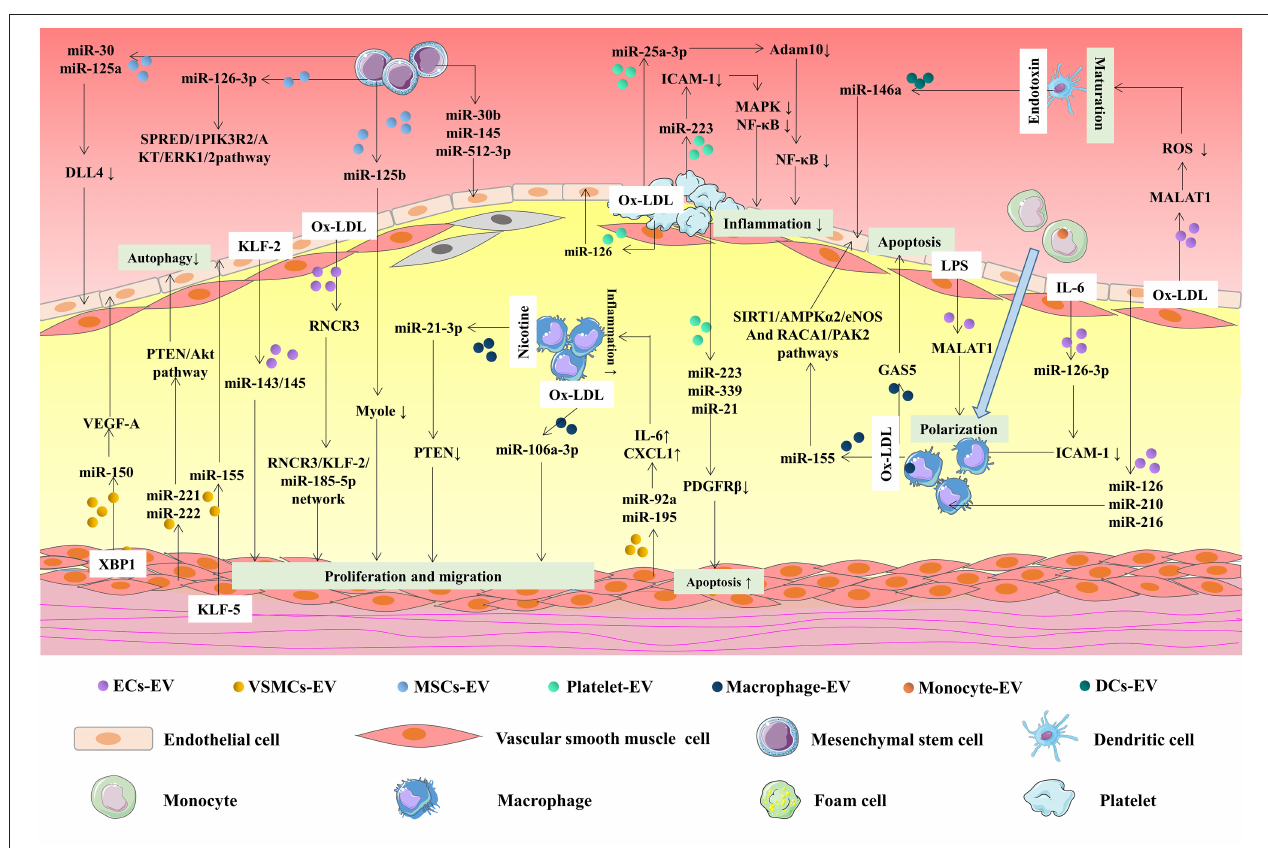
FIGURE 2 | MiRNAs and lncRNAs in EVs mediate intercellular communication in atherosclerosis. EVs, secreted by different cells, including ECs, VSMCs, and immune cells, are implicated in atherosclerosis via transferring miRNAs and lncRNAs. KLF2-expressing ECs-derived EVs reduced atherosclerotic lesion formation in ApoE (-/-) mice via delivering miR-143/145. Ox-LDL-induced ECs secret EVs regulate VSMCs proliferation and migration through the delivery of RNCR3. On the contrary, XBP1 splicing in VSMCs can control ECs migration via EVs inclusion of miRNA-150 and miRNA-150-driven VEGF-A/VEGFR/PI3K/Akt pathway. MiR-221/222 in VSMCs-derived EVs repressed HUVECs autophagy via PTEN/Akt pathway. MiR-155 was elevated in KLF5-overexpressing VSMCs-derived EVs and enhanced atherosclerosis development via inhibiting ECs proliferation, migration, and re-endothelialization. ECs-derived EVs carrying miRNA-126, miRNA-210, miRNA-216, and MALAT1 alleviate macrophages polarization and infiltration. The transfer of miRNA-126-3P to macrophages can reduce atherosclerotic plaque area via EVs. Overexpression of miR-155 in EVs from ox-LDL-induced macrophages regulated ECs inflammation by modulating Sirt1/AMPK α 2/eNOS and RAC1/PAK2 pathways. GAS5 was upregulated in THP-1 cells-derived EVs after oxLDL stimulation. GAS5 was involved in regulating ECs apoptosis and stimulating atherosclerosis. MiRNA-92a and miRNA-195 were increased in EVs from VSMCs and they could regulate inflammatory reaction through enhancing the expression of IL-6 and CXCL1 in macrophages. MiR-21-3p in EVs from nicotine-treated macrophages accelerate atherosclerosis by PTEN-mediated VSMC migration and proliferation. MiR-106a-3p was increased in EVs from ox-LDL stimulated THP-1 and it could promote cell proliferation of VSMCs. DCs-derived EVs transferred miRNA-146a into HUVECs to protect HUVECs from a second stimulation of TNF- α . Loss of MALAT1 in EVs from ox-LDL-induced VECs promoted DCs maturation in atherosclerosis development via Nrf2 pathway. MiR-25-3p was upregulated in thrombin-induced platelet-derived EVs and alleviated ox-LDL-induced ECs inflammation. Activated platelet-derived EVs promote ECs proliferation by transferring miRNA-126 and enhancing the production of VEGF, bFGF, and TGF- β 1. Thrombin stimulated platelet-derived EVs repressed the production of PDGFR β in VSMCs via the delivery of miR-223, miR-339, and miR-21, promoting cell apoptosis. MiRNA-30 and miRNA-125a in EVs released from MSCs reduced the expression of DLL4 in ECs, mediating angiogenesis. MSCs-derived EVs promote the proliferation and migration of ECs through delivering miRNA-126-3P. Besides, the transfer of miR-125b from MSCs-derived EVs to VSMCs inhibited VSMC proliferation by inhibiting